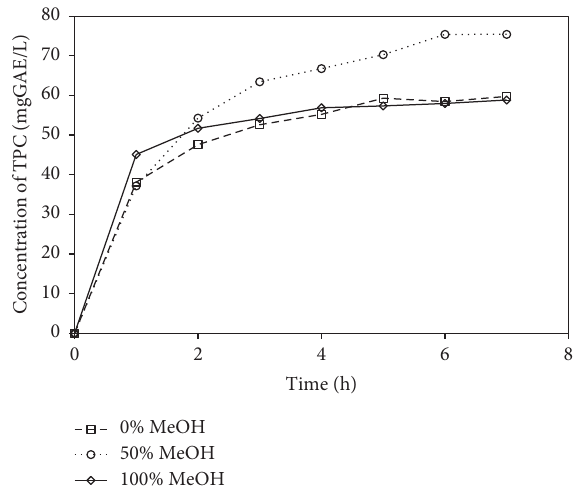
Figure 1: Effect of solvent composition on the concentration of TPC by batch